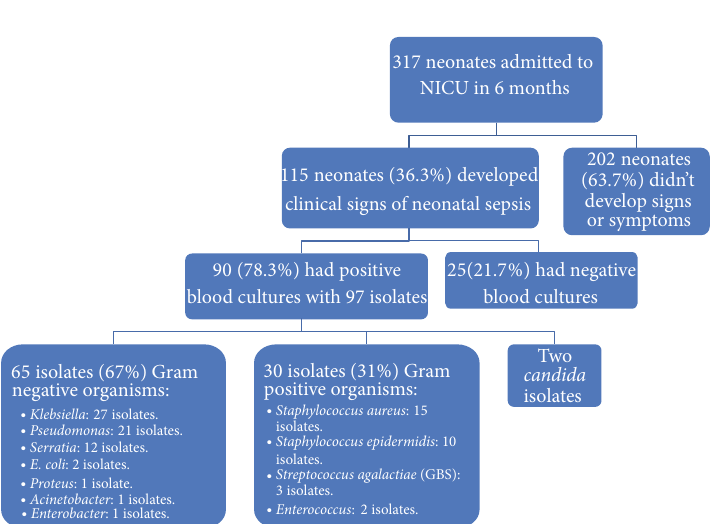
Figure 2: Study enrollment chart and pathogens recovered from neonatal blood